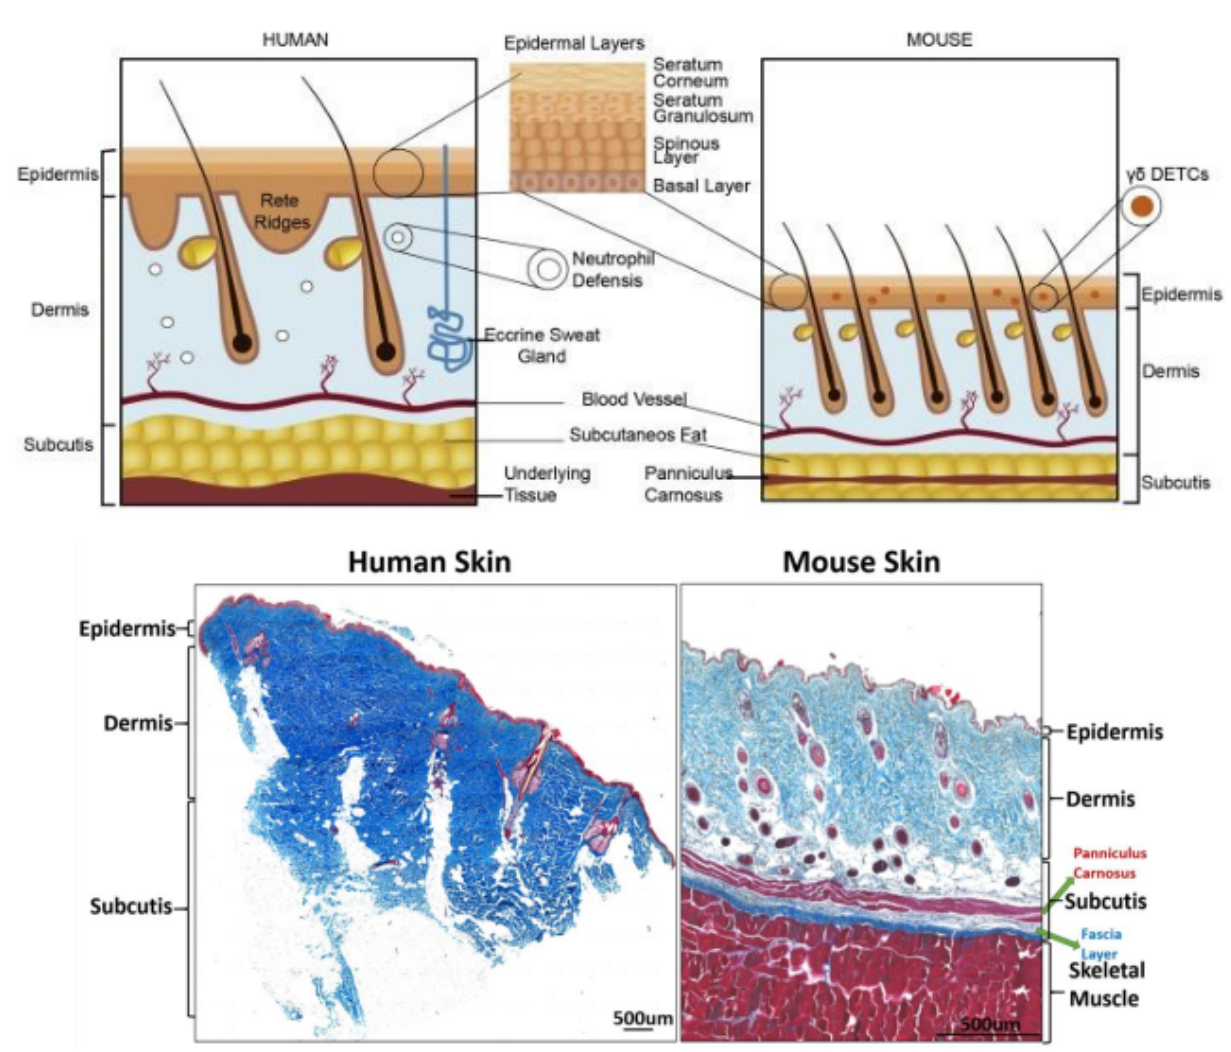
Figure 2. Histological differences between mouse and human skin. Above is a cartoon depiction of the difference between mouse and human skin. This image is a reference image [16]. Below is the histological difference between mouse and human skin, scale bar 500 µ